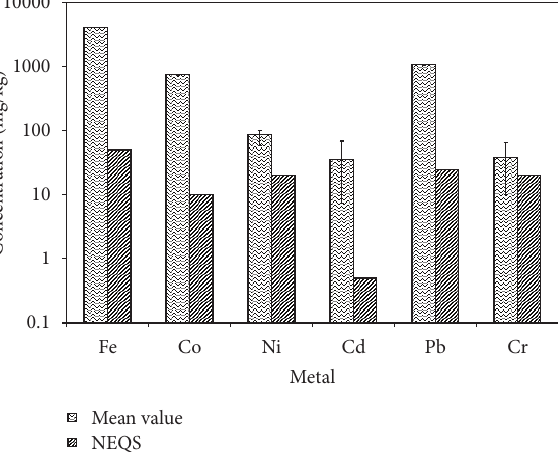
T2:Descriptivestatisticsformetallevels(mg/kg)insoil,plants,